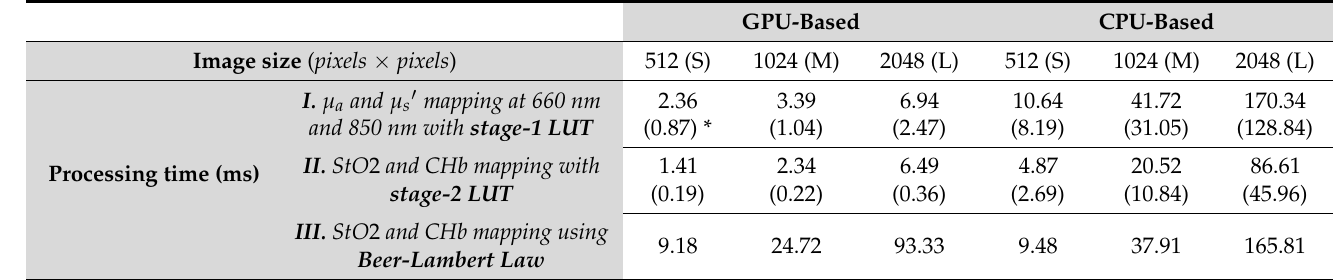
Table 1. Processing time for optical and perfusion property quantification with a GPU and CPU. GPU-Based